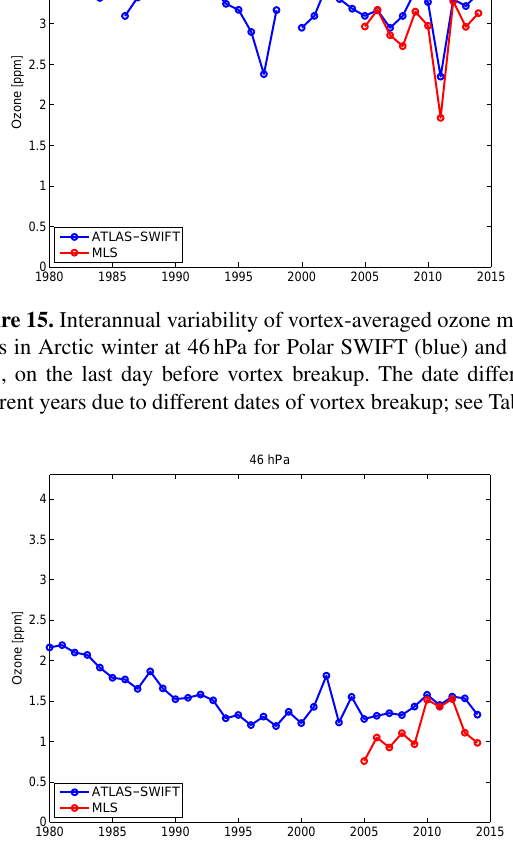
Figure 16. Interannual variability of vortex-averaged ozone mixing ratios in Antarctic spring at 46hPa on 1 October for Polar SWIFT (blue) and MLS